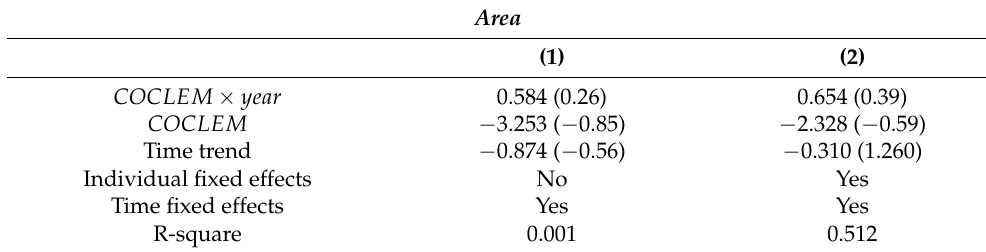
Table 3. Estimations of the effect of COCLEM on the SIL transaction area.